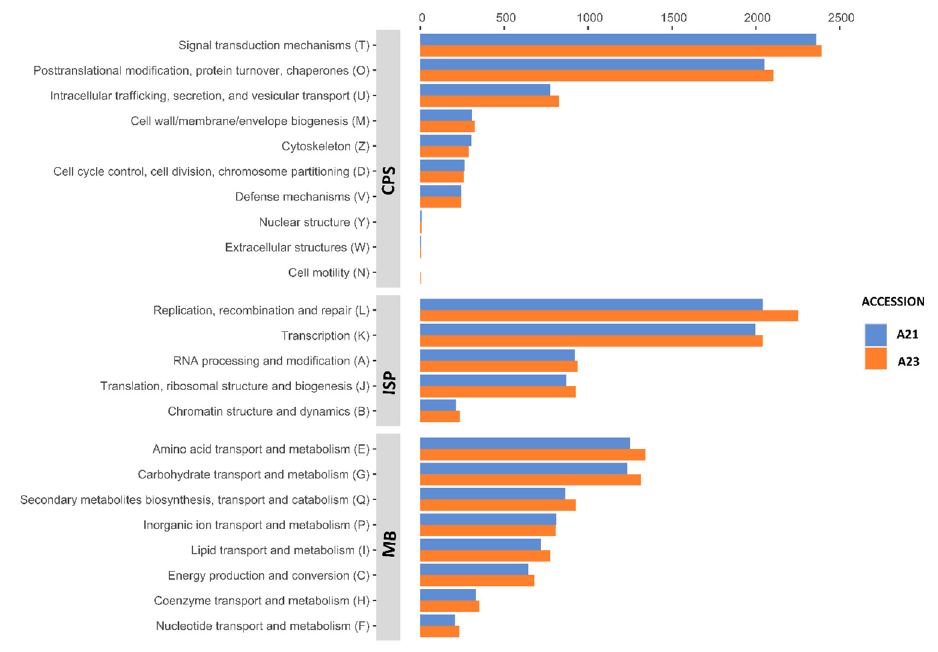
Figure 8. COG categories in the transcriptomes of tree tomato accessions A21 and A23.